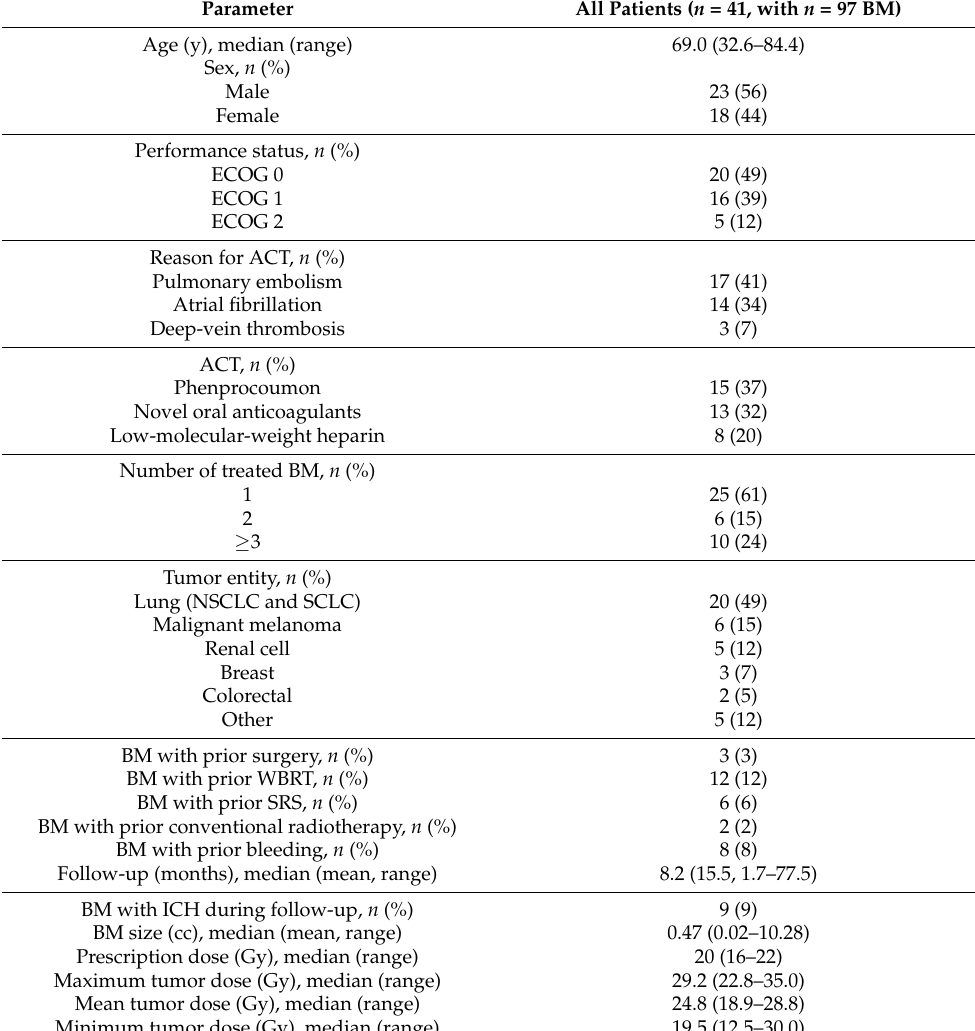
Table 1. Patient and treatment